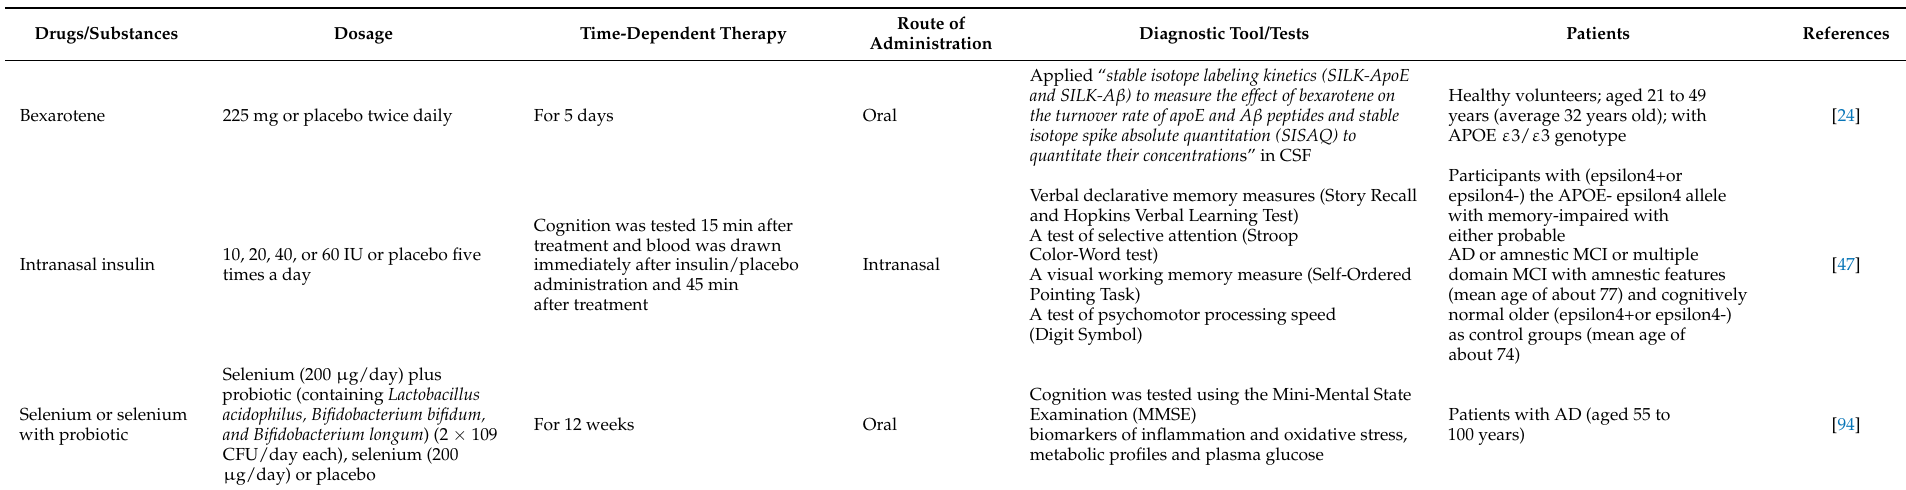
Table 3. Candidate drugs in selected clinical